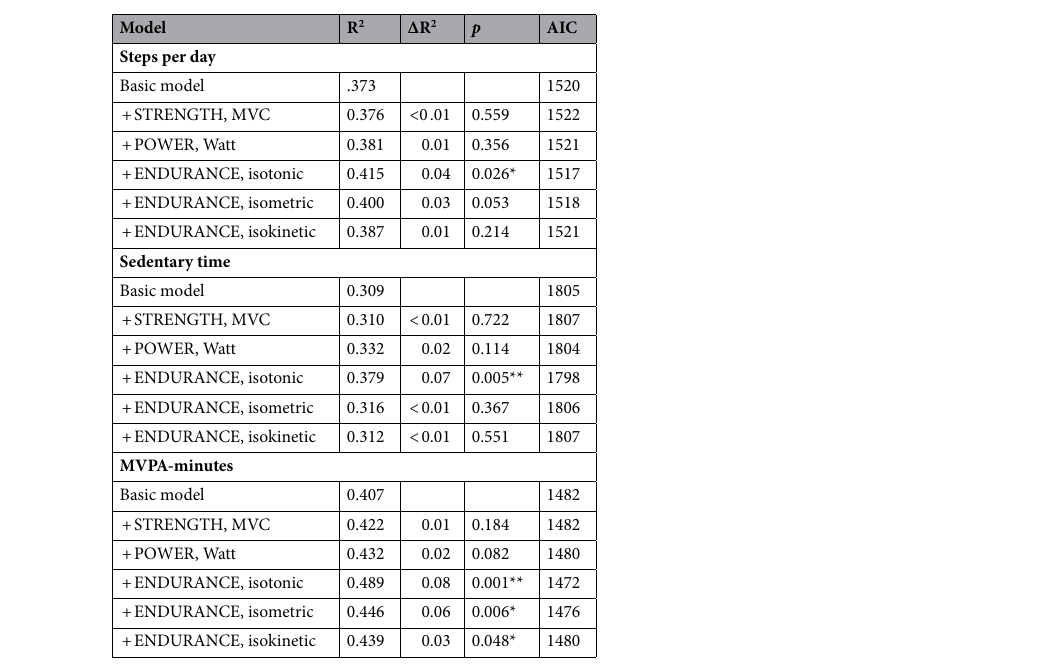
Table 3. Multiple linear regression analyses. The basic model includes; sex, age in years, body mass index, COPD Assessment Test score, forced expiratory volume in the first secondin % of predicted, and 6-minute walk test distance. ΔR 2 change in R 2 from the basic model. AIC Akaike information criterion, MVC maximal isometric voluntary contraction, MVPA time spent in moderate to very vigorous intensity. * p < .05, ** p < .01, *** p <